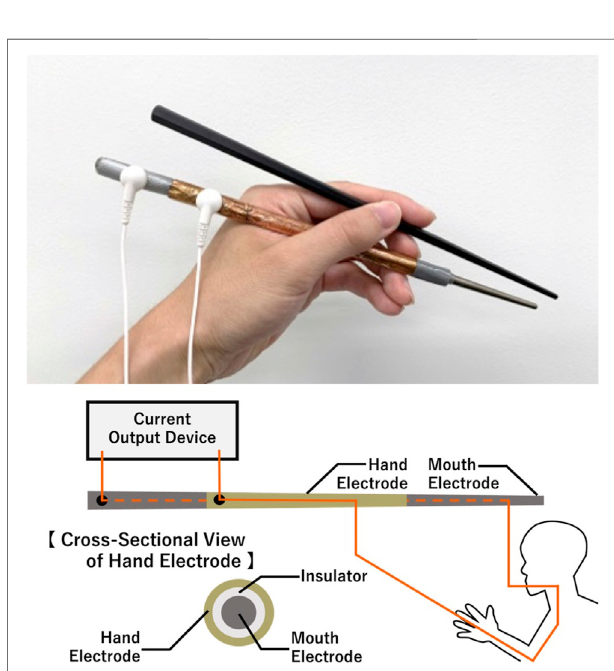
FIGURE3| Chopstickdeviceanditsstructure. (A) Chopstickdevice. (B) Structure of a chopstick device (Kaji and Miyashita, 2021).